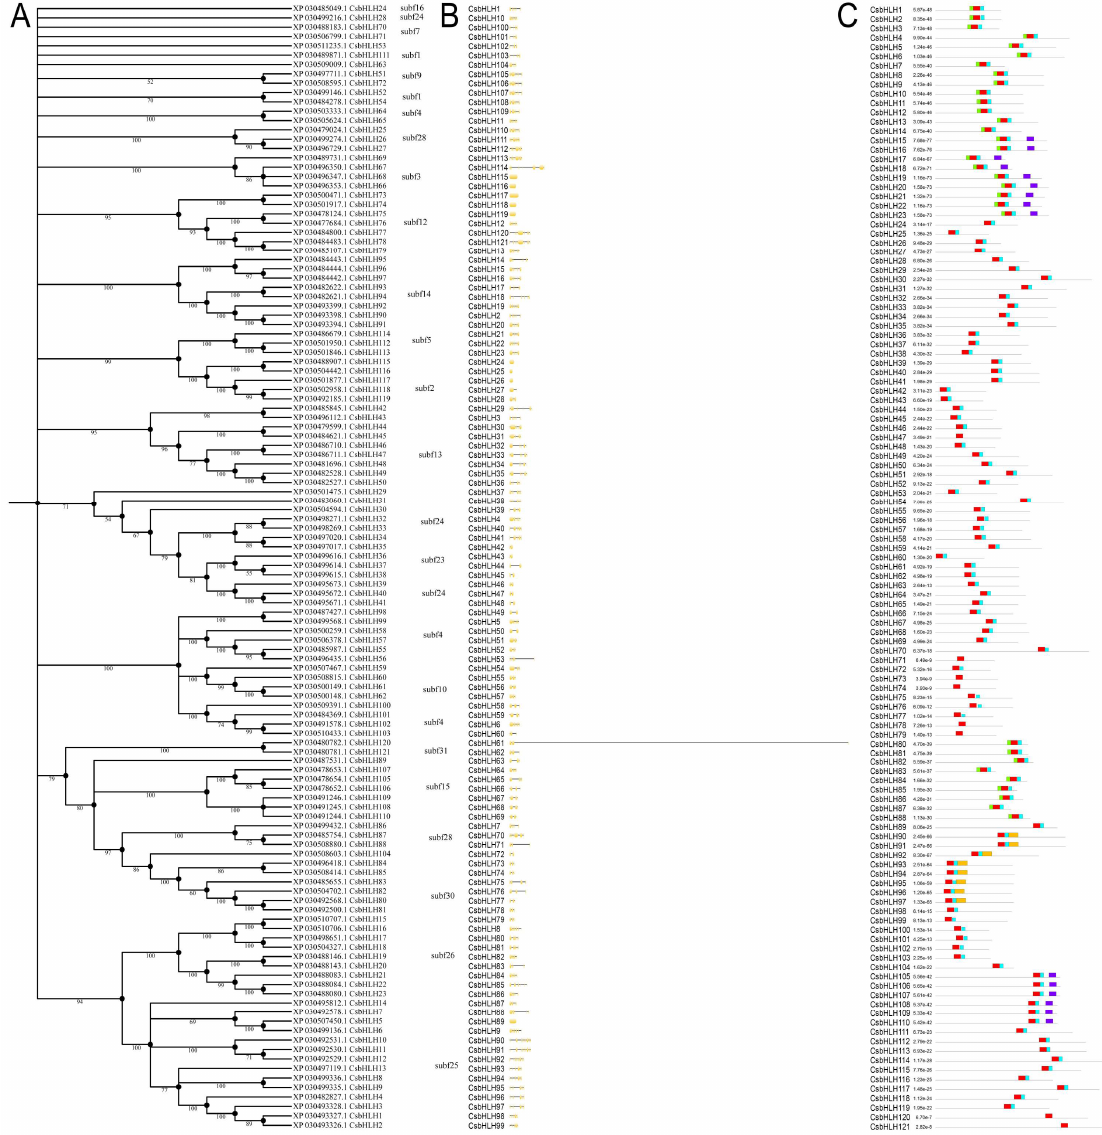
Figure 2. Phylogenetic analysis, gene structure, and motif distribution of Cannabis bHLH subfamilies. ( A ) Phylogenetic analysis of CsbHLHs. Amino acid sequences of the 121 CsbHLHs were used to construct the NJ tree using MEGA X with 1000 bootstrap replicates. Bootstrap values > 50 are shown on the branches. ( B ) Location and length of exons and introns of Cannabis bHLH family genes. Exons and introns are presented as filled yellow sticks and thin gray single lines, respectively. ( C ) MEME analysis of CsbHLHs motifs. Five kinds of colored blocks correspond to five di ff erent motifs in bHLH proteins. The length of gray line indicates the length of a sequence with respect to the total sequences dataset, while the position of each block represents for the location of a motif within a target sequence. Details of motifs consensus sequences are listed in Supplementary File